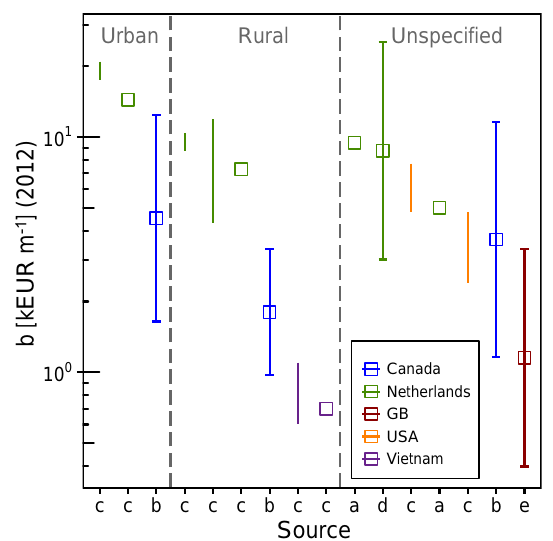
Figure 3. Comparison of our results with data from different stud- ies and countries in terms of unit cost estimates for raising dikes, namely (a) Hoozemans et al. (1993), (b) our estimate based on Del- can Corporation (2012), (c) Jonkman et al. (2013), (d) our estimate based on de Grave and Baase (2011), and (e) our estimate based on Pettit and Robinson (2012) using data from Delcan Corporation (2012). Boxes represent single-unit cost estimates, plain bars give ranges, and the boxes with error bars indicate our calculations with mean and 95% quantiles of the log-normal distributions. To make the data comparable, the values have been adjusted to EUR of 2012. The studies differ partly in the components taken into account (see main text). Please note that the cost axis is logarithmic. The values are listed in Table